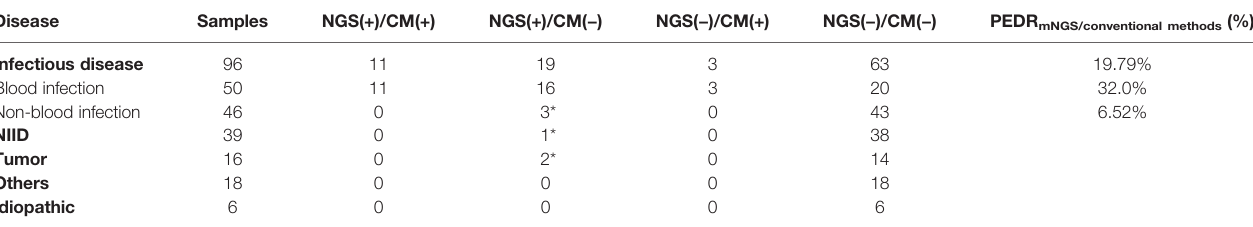
TABLE 4 | The diagnostic value of mNGS compared to conventional methods in blood samples in FUO. Disease